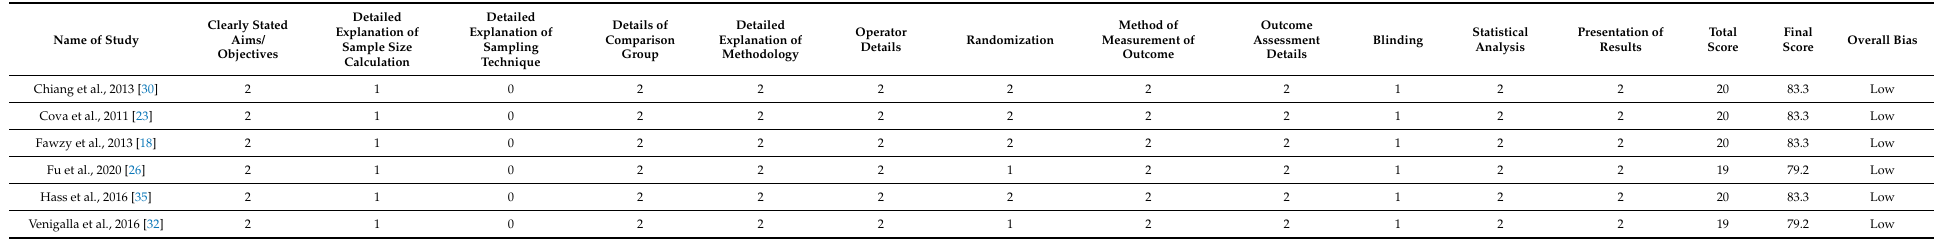
Table 4. Risk of bias of the included